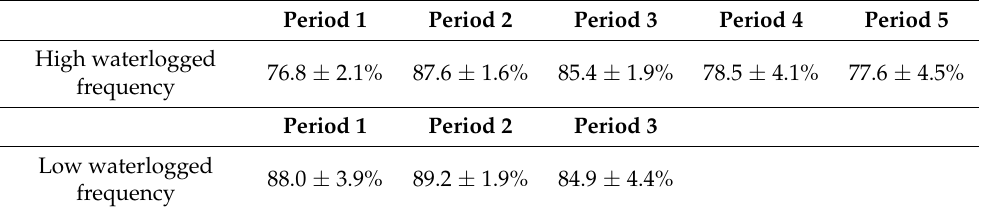
Table 2. Average removal rate of effluent total nitrogen under different waterlogged frequencies.